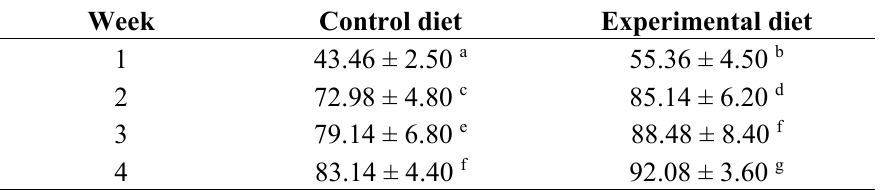
Table 4. Effect of feed on efficiency of conversion of ingested feed